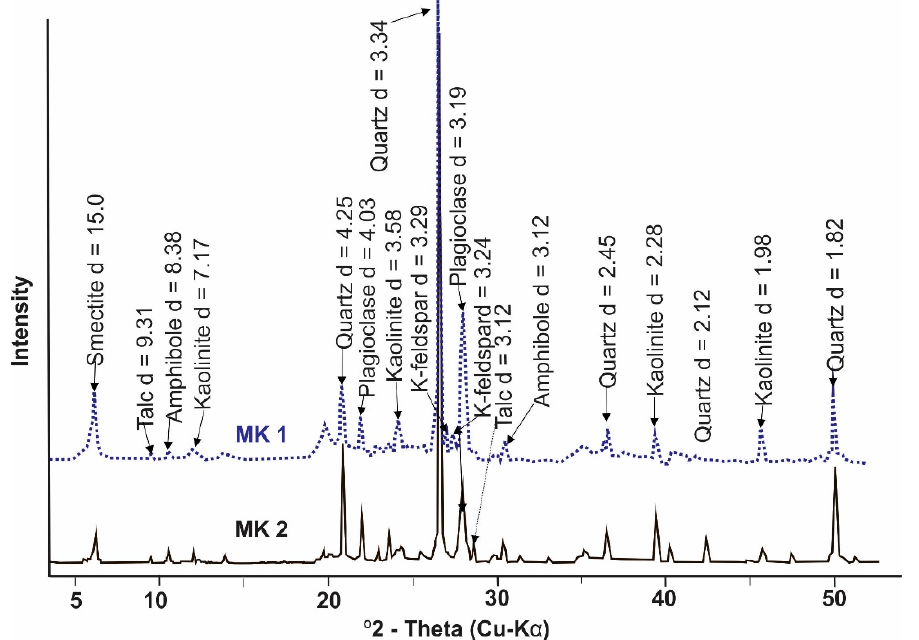
Table 2. Mineralogical composition of raw clay materials (%) .